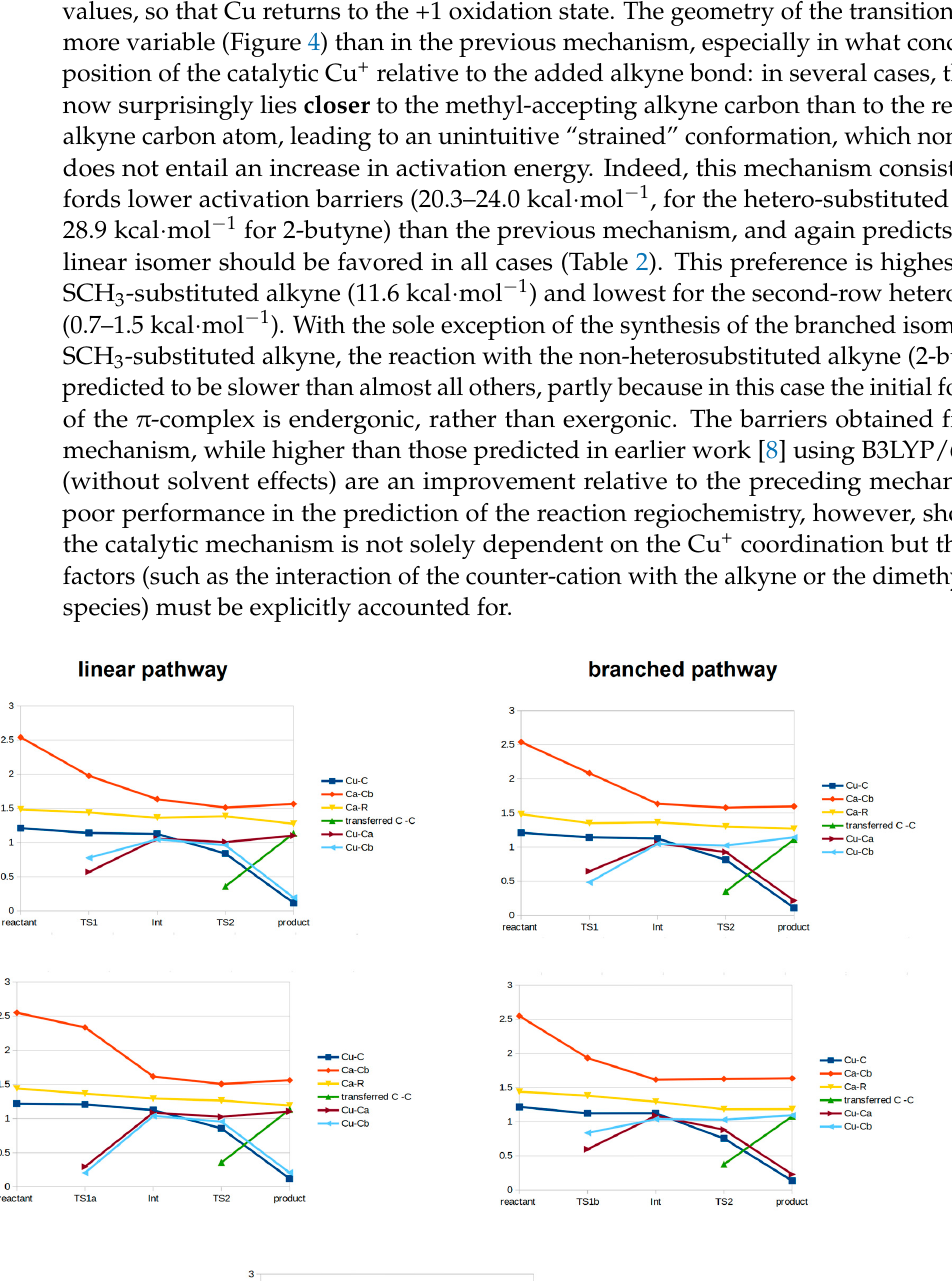
Figure 3. Evolution of fuzzy bond orders in the methyl transfer from [Cu(CH 3 ) 2 ] - to alkynes of the form R-C ≡ C-CH 3. C a and C b refer (respectively) to the alkyne-bond carbon linked to the heteroatom and to the alkyne-bond carbon linked to the methyl group.